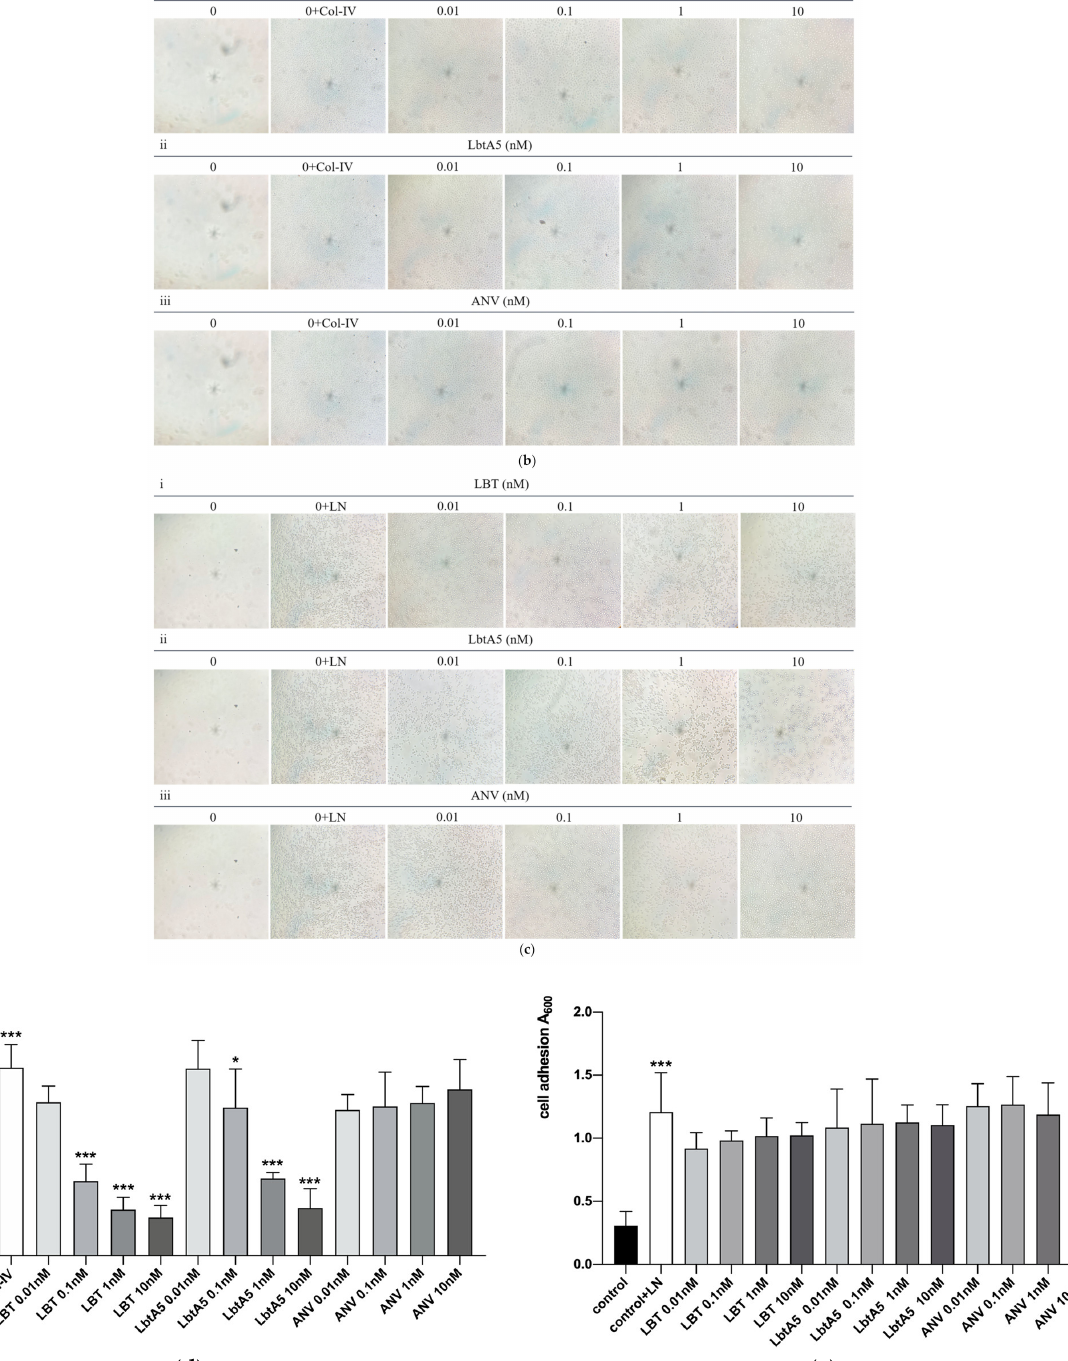
Figure 3. Analysis of PC12 and HT29 cell adhesion. ( a ) Analyses of the purified lbt by SDS–PAGE on a 12% resolving gel. The gel was stained with Coomassie blue R-250. Lane 1: pGEX-6p-1-lbt without IPTG induction; Lane 2: whole protein after sonication of the bacteriophage; Lane 3: supernatant protein after centrifugation. Lane 4: precipitated protein after centrifugation; Lane 5: 10 mM GSH-eluted lbt; ( b , c ) PC12 and HT29 cells were observed with an ordinary light microscope at 100×; ( d , e ) PC12 and HT29 cells treated with different concentrations of lbt, LbtA5, and ANV. After treatment, the cells were incubated at 37 °C and 5% CO 2 for 24 h and photographed at 100× with an ordinary light microscope. Mean ± SD, n = 6, * p < 0.05, *** p < 0.001 using one-way ANOVA, both compared to control.